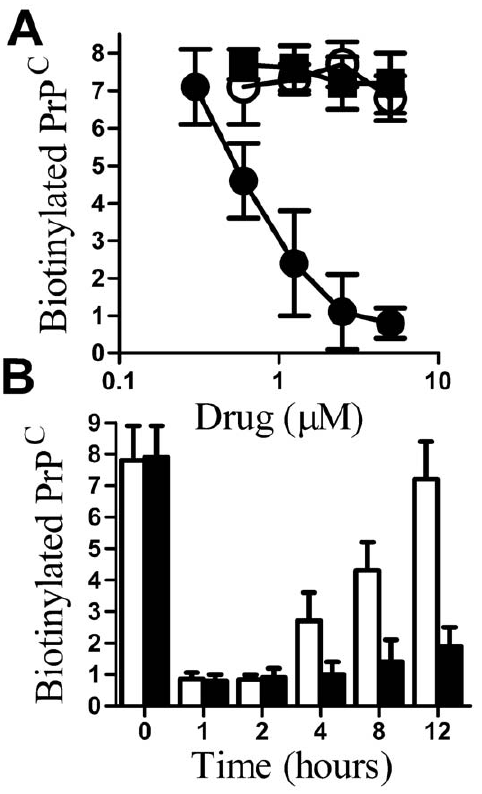
Figure 2. Glimepirde reduced the amount of PrP C at the surface of neurones. (A) The amount of cell surface PrP C on neurones treated for 1 hour with different concentrations of glimepiride ( # ) or glipizide ( & ) as shown. Values shown are the mean average amount of biotinylated PrP C in cell extracts (ng/10 6 cells) 6 SD, n=9. (B) The amount of cell surface PrP C in cell extracts from cortical neurones taken at different time points after the addition of 5 m M glimepiride alone ( % ) or a mixture containing 5 m M glimepiride and 20 m g/ml cycloheximide ( & ) as shown. Values shown are the mean average amount of biotinylated PrP C in cell extracts (ng/10 6 cells) 6 SD, n=9.